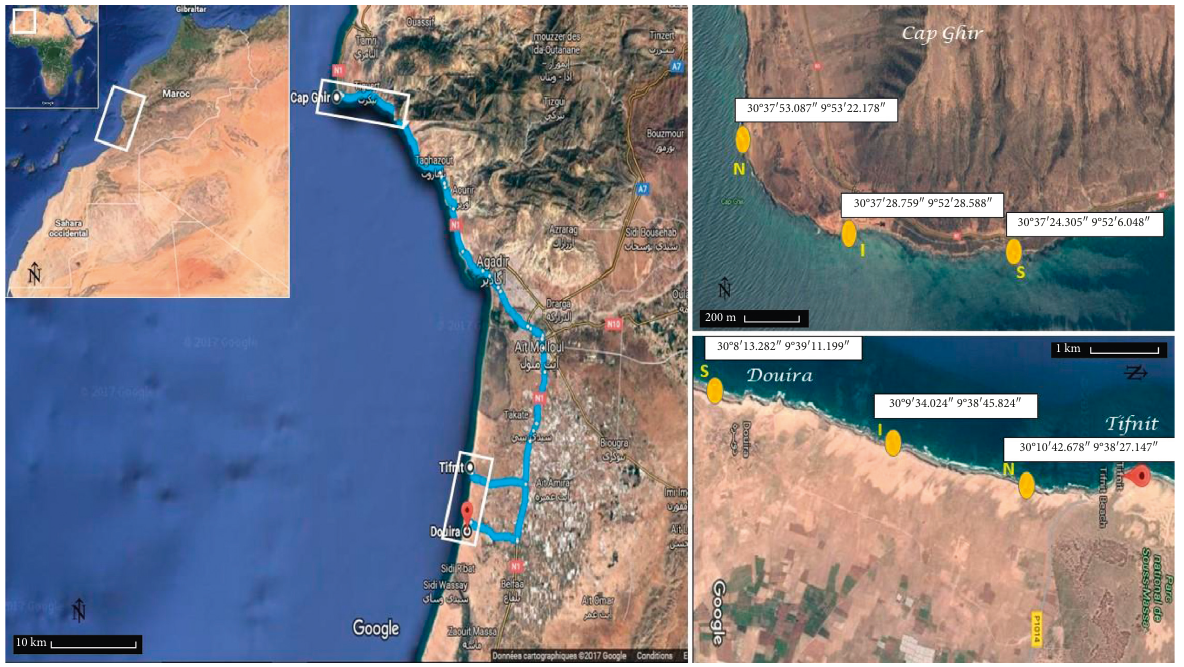
Figure 1: Map of the sampled sites in the coastline: Cap Ghir in the north and Tifnit-Douira in the south of Agadir (Morocco) (South (S), Instal (I), and North (N)), and the distance between the sites is >